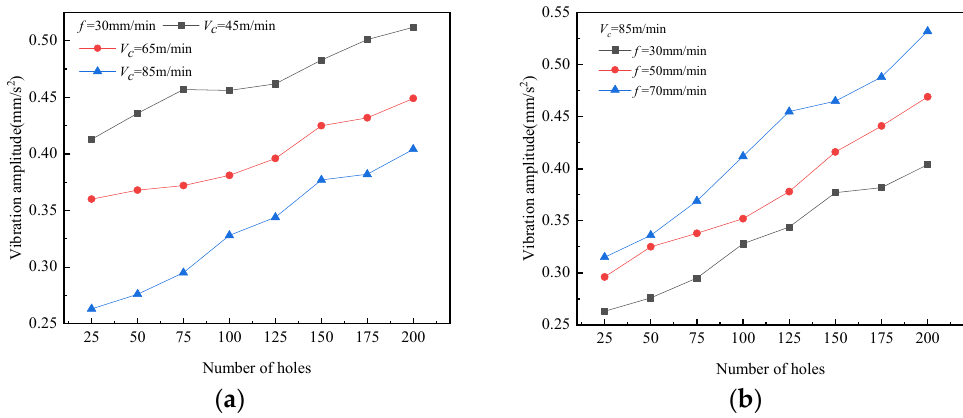
Figure 11. Effect of tool wear on the vibration amplitude: ( a ) different cutting speeds; ( b ) different feed rates.